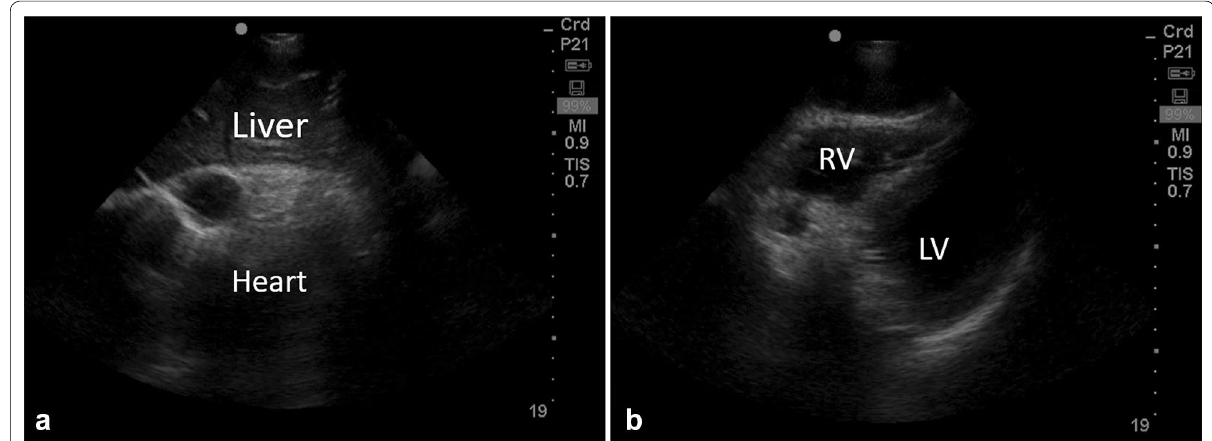
Fig. 2 Subcostal views of the heart taken while chest compressions were ongoing. a The heart was compressed (systole) and chambers are difficult identify. b The hands are off the chest and the right (RV) and left (LV) ventricles are seen clearly